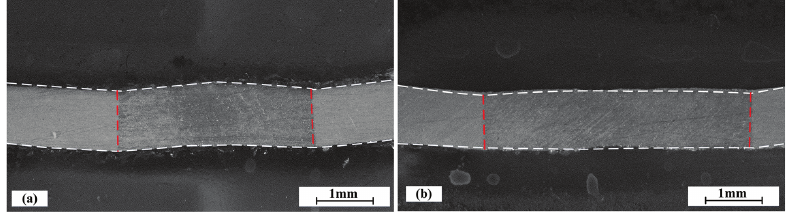
Figure 11: Weld stereomicroscope images under different laser powers of (a) sheet No. 9 and (b) sheet No. 10.